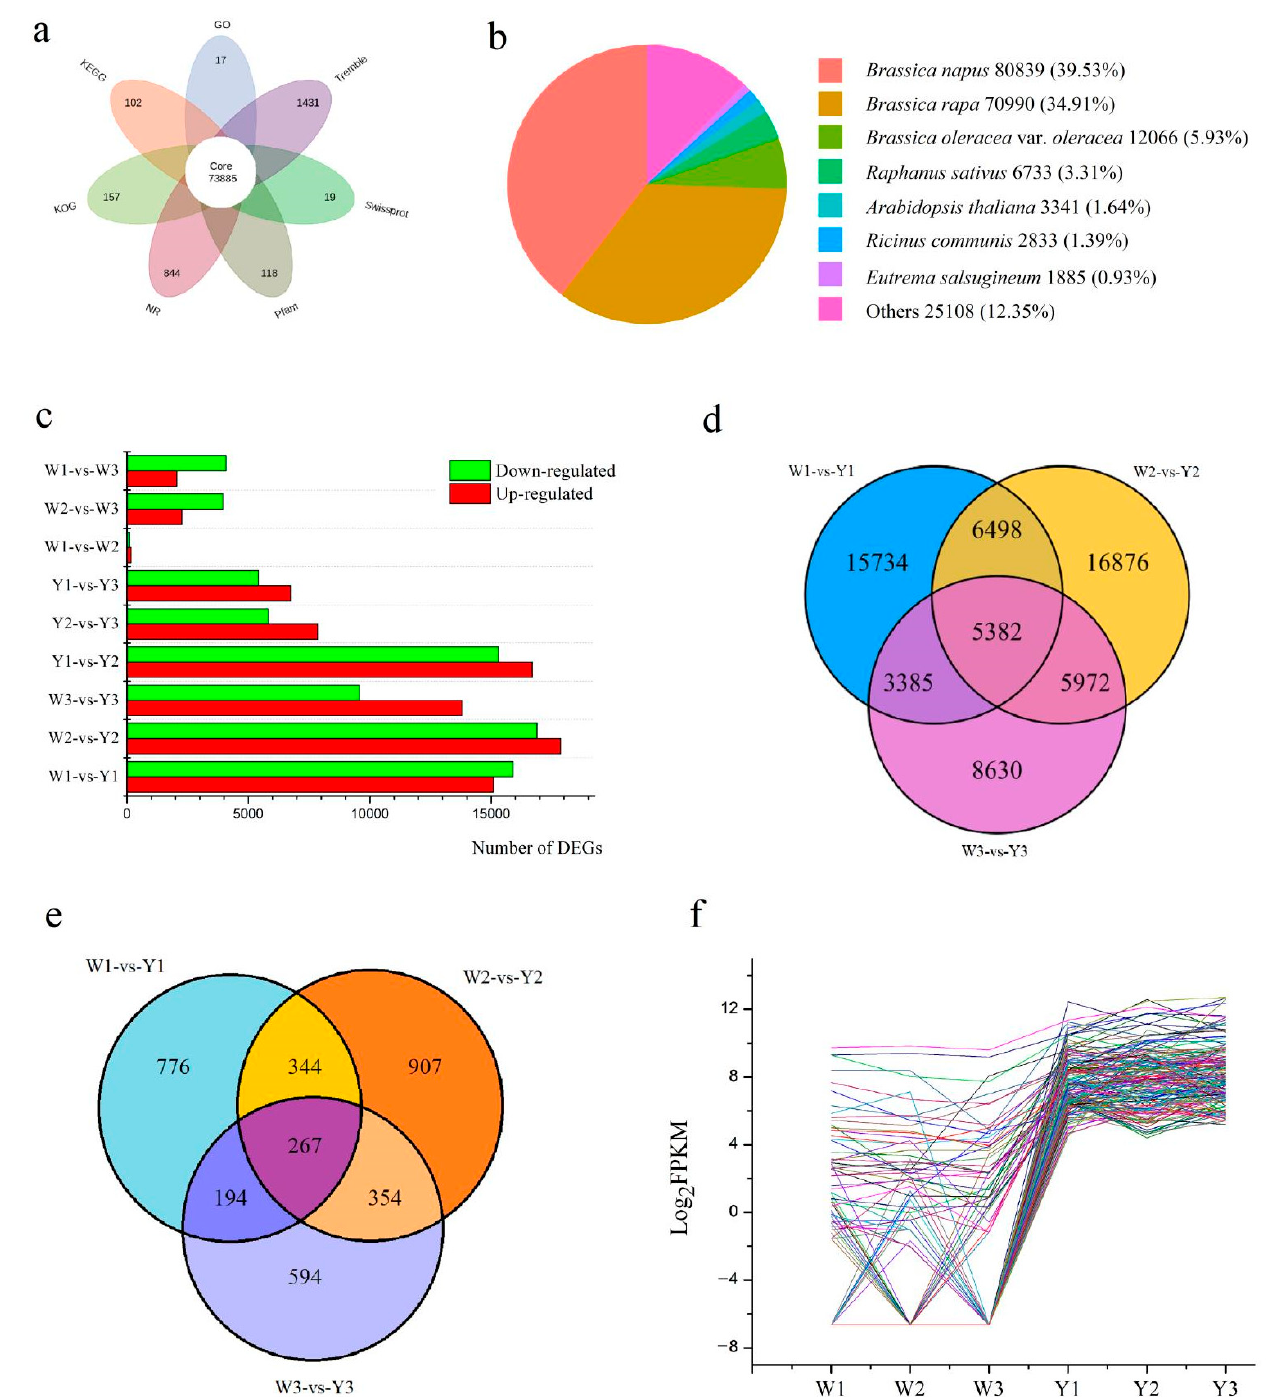
Figure 2. Unigene annotation and identification of DEGs in two turnips. ( a ) The petal diagram of number of unigenes annotated in seven databases. ( b ) The top BLAST hit species based on the unigene annotation of turnip fresh root. ( c ) DEGs in different pairwise comparisons. ( d ) Venn diagram of DEGs in W1-vs-Y1, W2-vs-Y2 and W3-vs-Y3. ( e ) Venn diagram of differentially expressed transcription factors in W1-vs-Y1, W2-vs-Y2 and W3-vs-Y3. ( f ) The trend change map of 163 transcription factors shows higher expression level in W25 than in W21 in all three pairwise comparisons of W1-vs-Y1, W2-vs-Y2 and